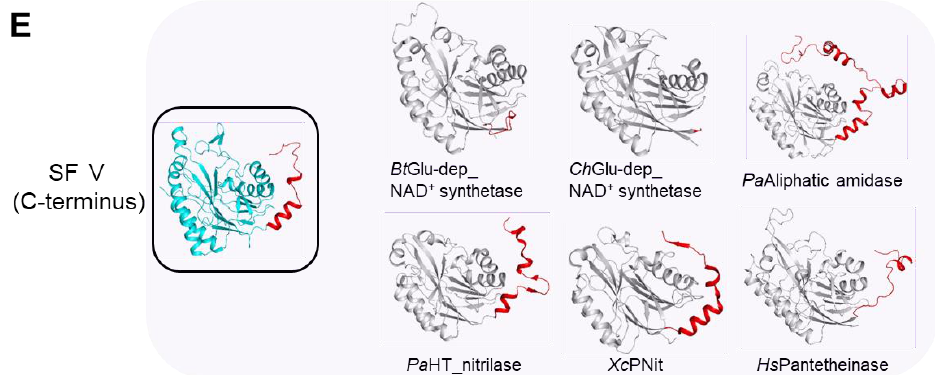
Figure 8. Five distinct structural features. ( A ) The representative structures containing structural feature I (SF I) according to the α2 helix. The KlNit2 structure is colored in cyan within a black rectangular box. The two structural homologs with a different conformation of the α2 helix are shown in gray. The α2 helix is shown in red. The two homologous structures indicate the follow-